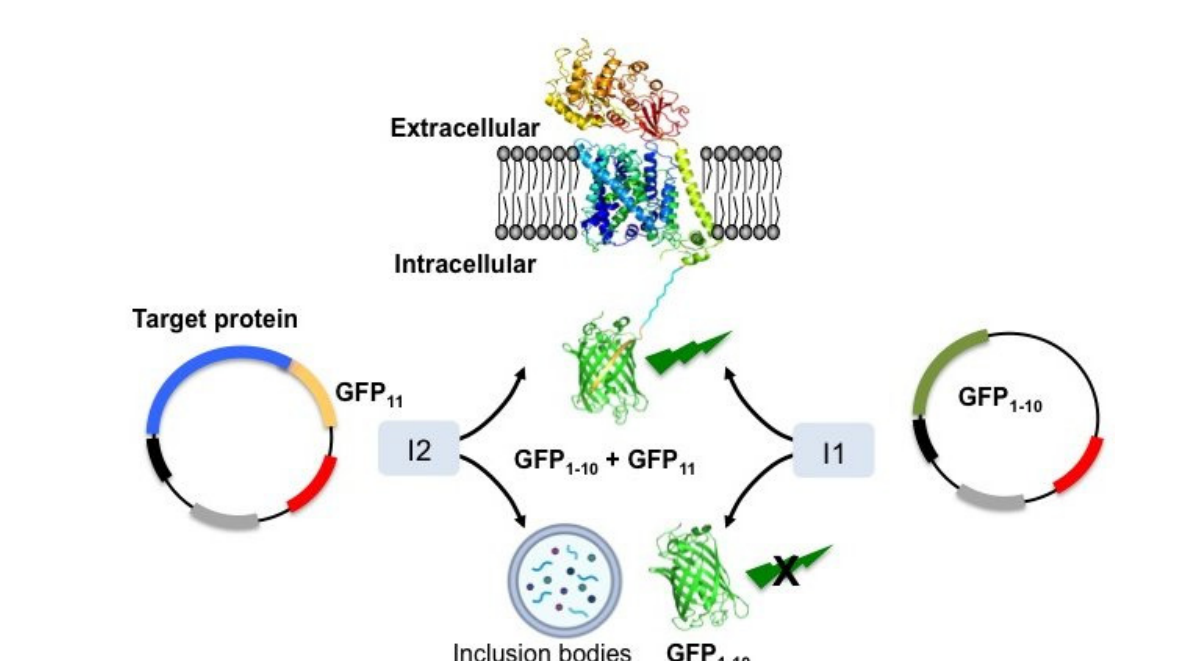
Figure 1. Schematic representation of the split GFP assay as reporter of membrane protein expression and stability in the membrane. The split GFP assay consists of two plasmids: one containing the target membrane protein fused to GFP strand 11 ( left ) and another plasmid expressing GFP strands 1 to 10 ( right ). Protein expression is controlled by two promoters activated by different inducers (I1 and I2). Inducing these two genes sequentially allows the identification of target membrane protein variants that are expressed and inserted into the plasma membrane of the expression system, since the two fragments of the GFP complements resulting in fluorescence emission. Variants confined into inclusion bodies show no fluorescence as no complementation